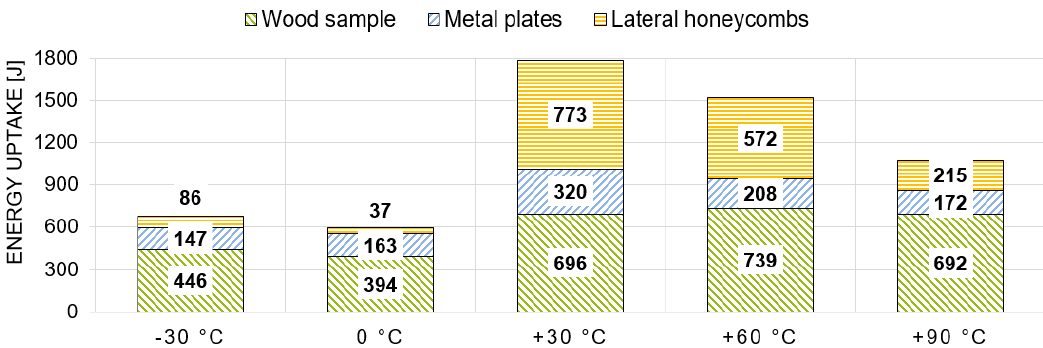
Figure 14. Energy distribution of the samples under quasi-static loading in tested temperature series, restricted to internal energy.